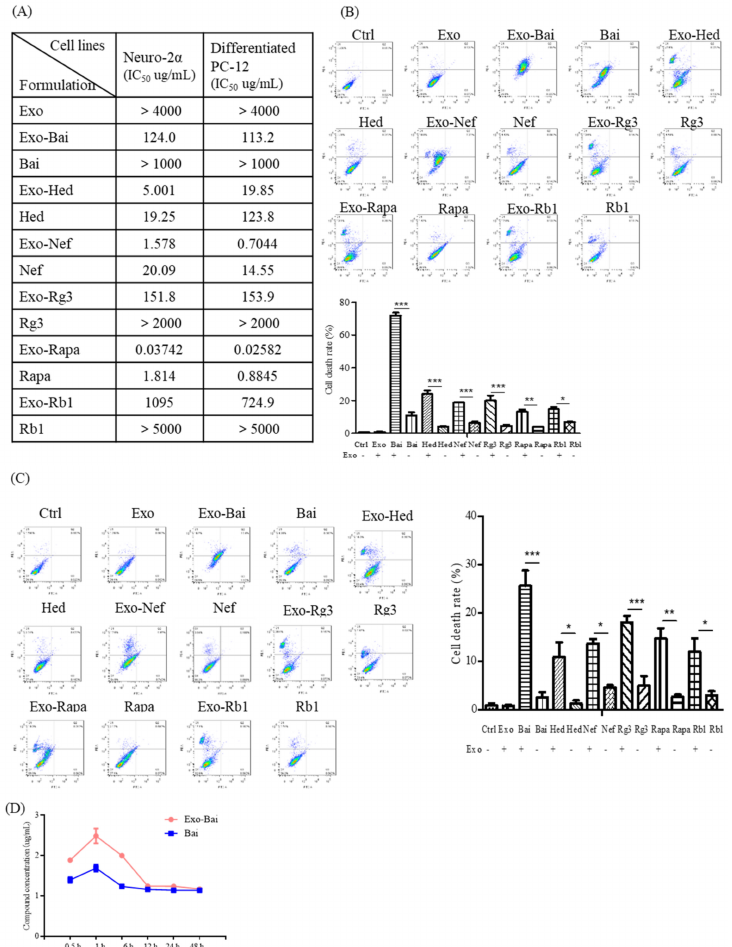
Figure 4. Exosome-encapsulated herbal compounds increase the cellular toxicity of different cell lines. ( A ) Cytotoxicity MTT assays of the Exo-compounds (the concentrations of Exo, Exo-Bai, Exo-Hed, Exo-Nef, Exo-Rg3, Exo-Rapa or Exo-Rb1 were 4000 µ g/mL, 1000 µ g/mL, 200 µ g/mL, 5 µ g/mL, 2000 µ g/mL, 5 µ g/mL and 5000 µ g/mL, respectively) and herbal compounds alone (the concentrations of Bai, Hed, Nef, Rg3, Rapa and Rb1 were 1000 µ g/mL, 200 µ g/mL, 50 µ g/mL, 2000 µ g/mL, 5 µ g/mL, 5000 µ g/mL, respectively) were performed on both the differentiated PC-12 cells and neuron-2a cells by the MTT method after 48 h of the compound treatments. ( B ) Flow cytometric measurements of the cytotoxicity of Exo-compounds (the concentrations of Exo-Bai, Exo- Hed, Exo-Nef, Exo-Rg3, Exo-Rapa or Exo-Rb1 were 150 µ g/mL, 3 µ g/mL, 0.6 µ g/mL, 100 µ g/mL, 200 ng/mL, 600 µ g/mL, respectively) and herbal compounds alone (the concentrations of Exo, Bai, Hed, Nef, Rg3, Rapa or Rb1 were 150 µ g/mL, 3 µ g/mL, 0.6 µ g/mL,100 µ g/mL, 200 ng/mL, 600 µ g/mL, respectively) were validated on differentiated PC-12 cells and ( C ) Neuron-2a cells by flow cytometry after 24 h of the compound treatment. ( D ) The intracellular concentration of Bai on differentiated PC-12 was determined by UHPLC-MS at 0.5 h, 1 h, 6 h, 12 h, 24 h and 48 h after treatment with 10 µ g/mL of Exo-Bai or Bai alone. All of the experiments were performed as three independent experiments. One-way ANOVA was used to compare the data: * p < 0.05, ** p < 0.01, *** p <